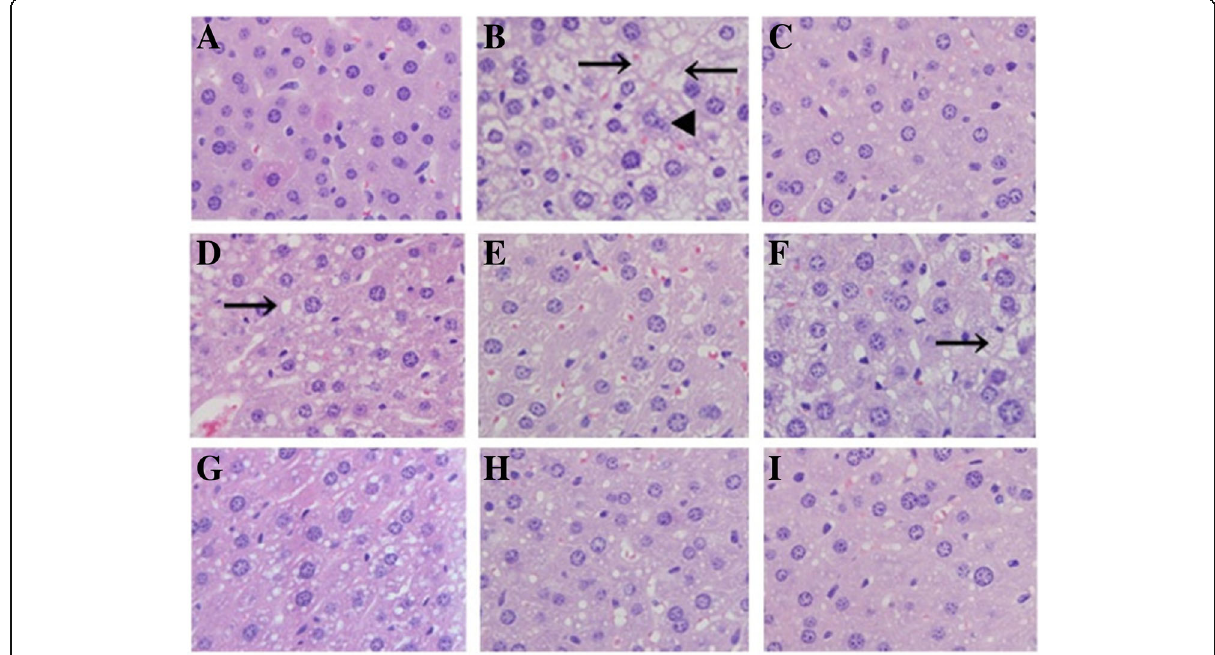
Fig. 5 Effects of EPS, EEPS and AEPS on hepatic cells in the hyperglycemia mice (hematoxylin-eosin staining, 400×). ( a ) NC group, ( b ) HL group, ( c ) ST group, ( d ) L-EPS, ( e ) H-EPS, ( f ) L-EEPS, ( g ) H-EEPS, ( h ) L-AEPS and ( i ) H-AEPS ( n = 8). Arrows show fat granule in cell, triangles indicate condensation or disappearance of cellular